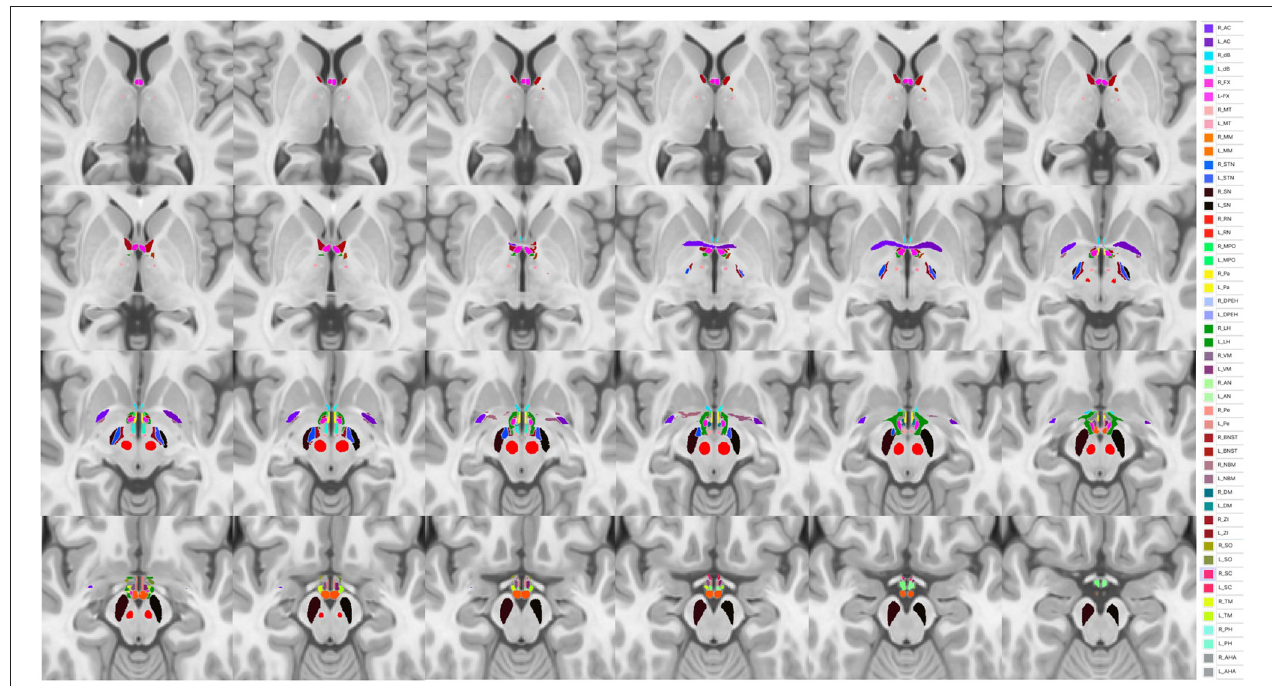
FIGURE 3 | Projection of the Neudorfer hypothalamic atlas into a homemade 7T MP2RAGE Uni-Den template. Ac, anterior commissure; AHA, anterior hypothalamic area; AN, arcuate nucleus; BNST, bed nucleus of stria terminalis; dB, diagonal band of Broca; DM, dorsomedial hypothalamic nucleus; DPEH, dorsal periventricular hypothalamus; FX, fornix; LH, lateral hypothalamus; MM, mammillary bodies; MPO, medial preoptic nucleus of the hypothalamus; MT, mammillothalamic tract; NBM, nucleus basalis of Meynert; Pa, paraventricular nucleus; Pe, periventricular nucleus; PH, posterior hypothalamus; RN, red nucleus; SC, suprachiasmatic nucleus; SN, substantia nigra; SO, supraoptic nucleus; STN, subthalamic nucleus, TM, tuberomammillary nucleus; VM, ventromedial nucleus; ZI, zona